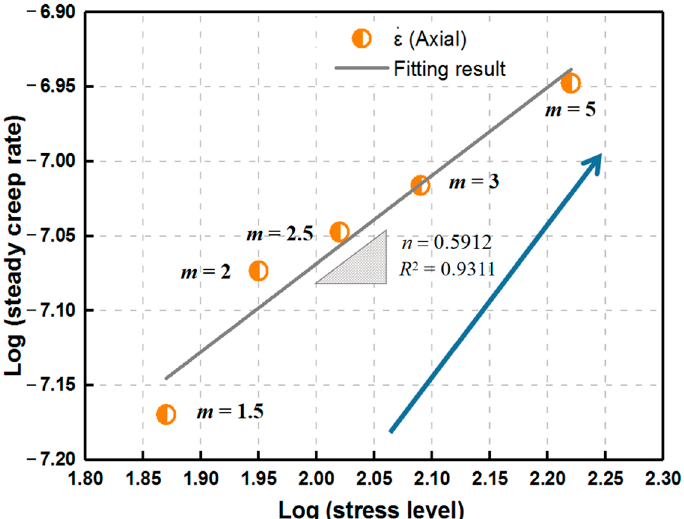
Figure 9. Relationship between the last stress level and steady creep rate for various homogeneity indexes during uniaxial creep loading.